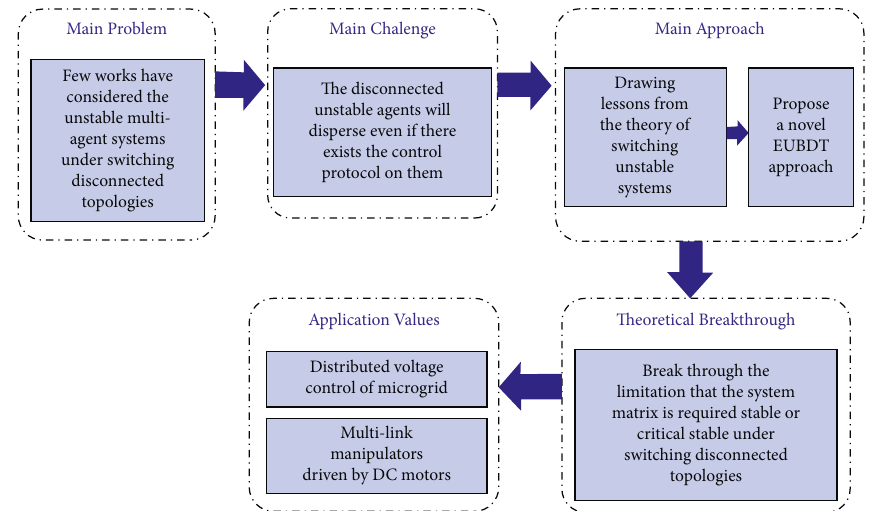
Figure 1: The flow diagram of the main